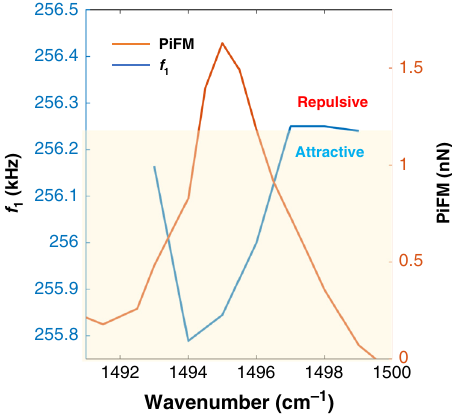
Fig. 2 Cantilever frequency shift across an absorption band. Shift of the cantilever resonance frequency at f 1 (blue line) across PS absorption band at 1495 cm − 1 (orange line). The sample is 60-nm-thick PS fi lm on Au substrate. Input average power was 1 mW focused to 20- μ